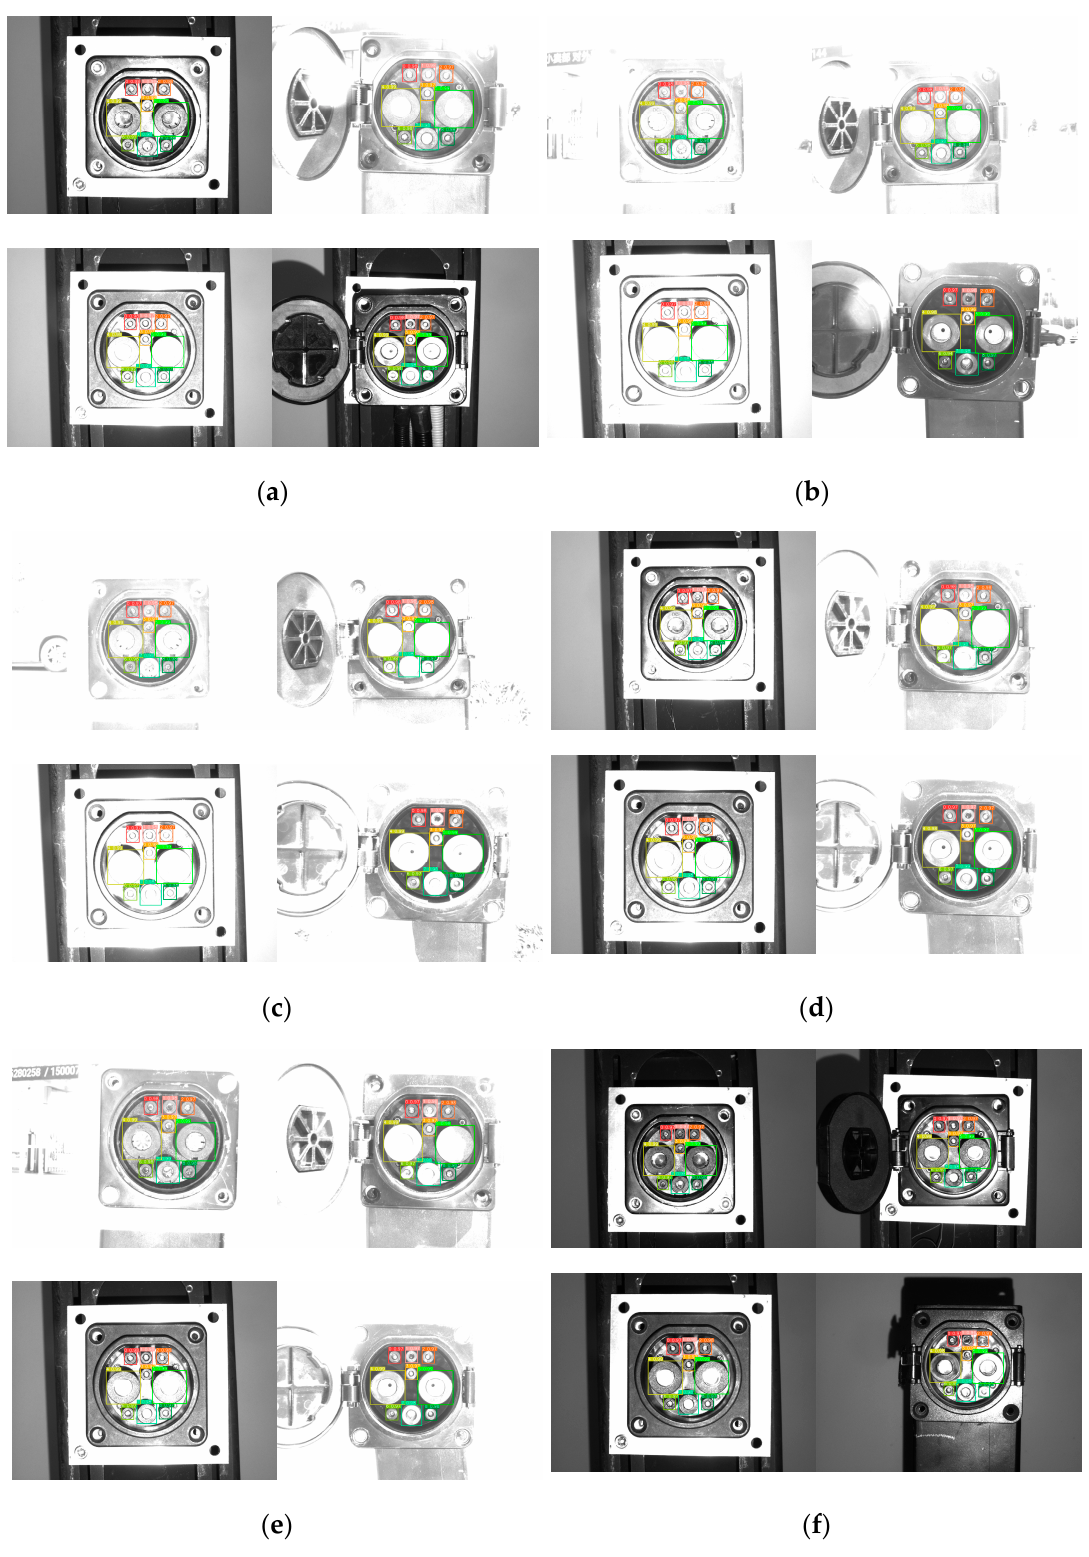
Figure 8. Recognition performance in different scenarios in the PPS: ( a ) all indoor scenes; ( b ) outdoor sunny morning/afternoon; ( c ) outdoor sunny noon; ( d ) outdoor cloudy morning/afternoon; ( e ) out- door cloudy noon; ( f ) all scenes at night. Table 6. Comparison of di ff erent recognition methods in PPS.